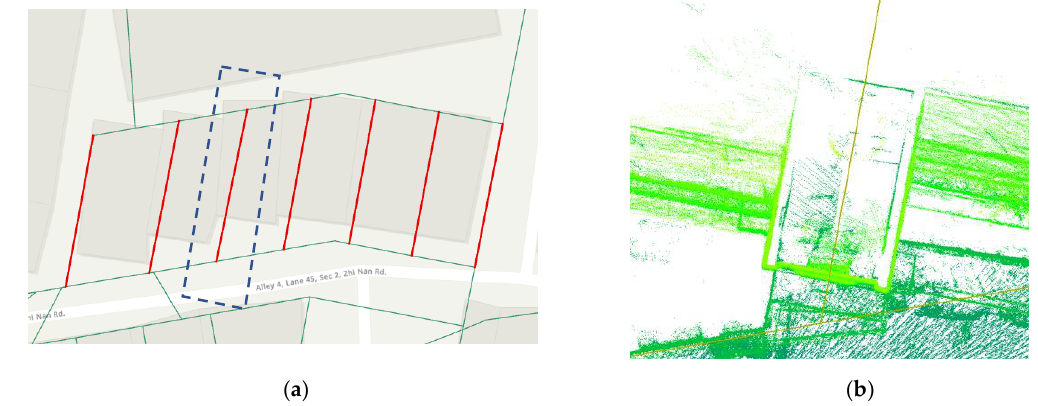
Figure 19. An example of the possible cadastral detail line between townhouses. ( a ) The digitized possible cadastral detail lines. ( b ) Overlap of point cloud and the cadastral map.